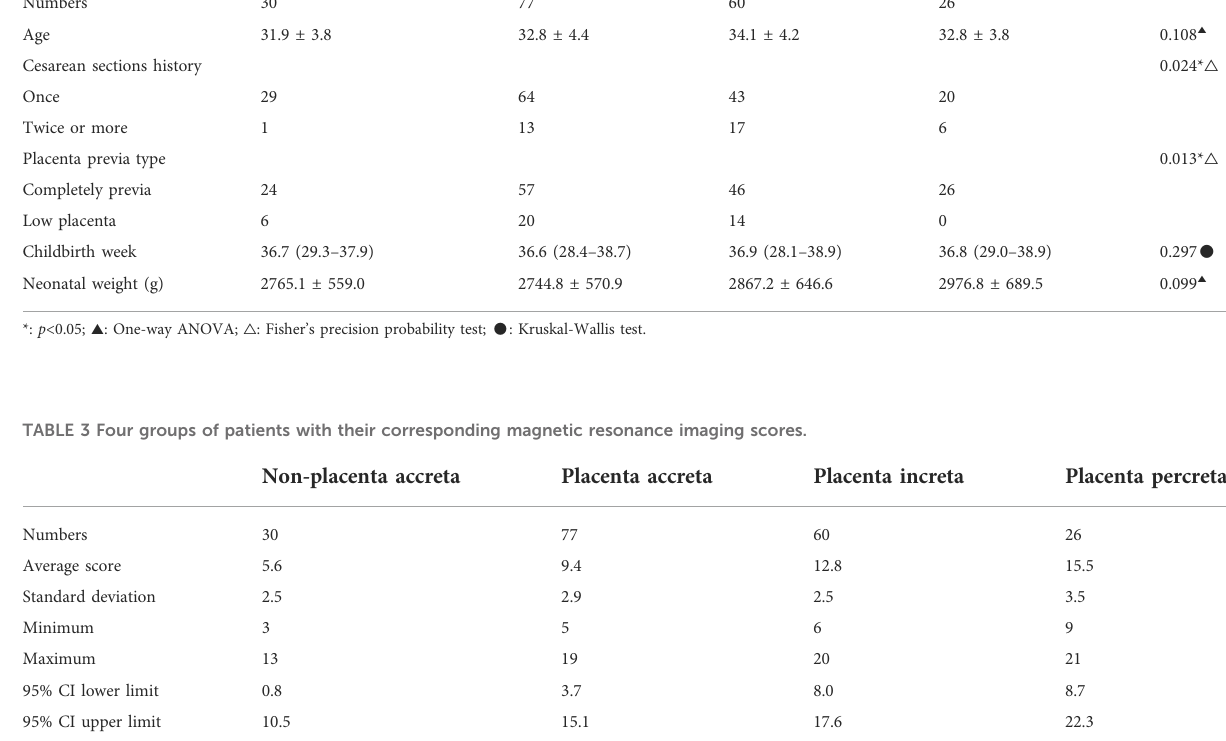
diagrammatic representation abnormal vascularization of the placental bed is demonstrated by prominent vessels in the placental bed with disruption of the uteroplacental interface, and the vessels may be accompanied by extensive neovascularization around the bladder, uterus, and vagina. Heterogeneous placenta is represented on the diagram as altered background parenchymal